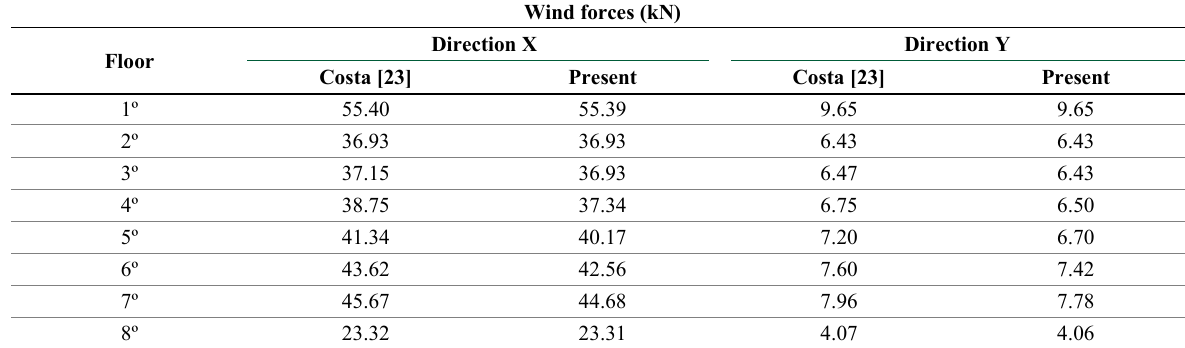
Table 2. Comparison of results.